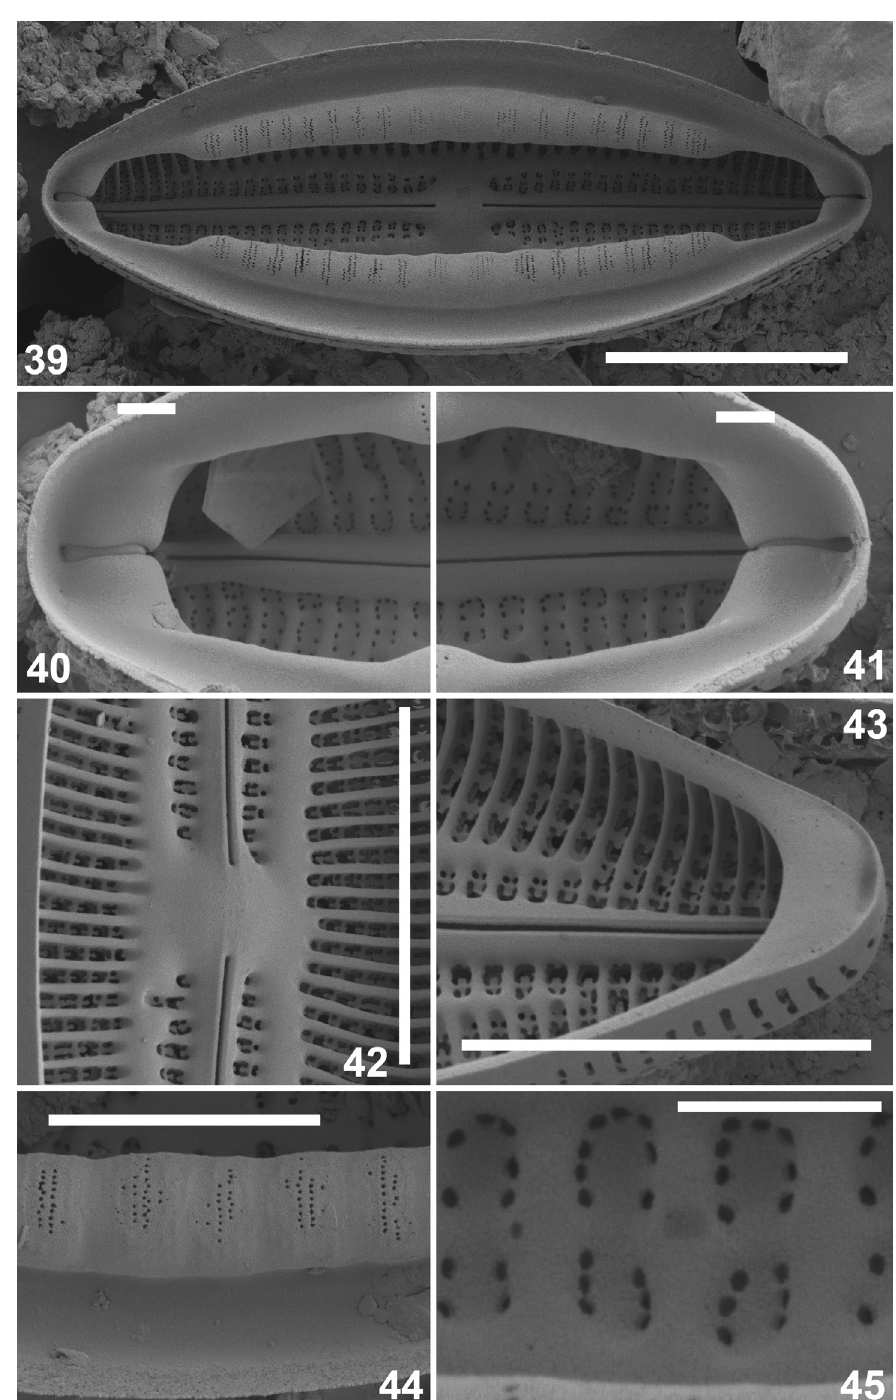
Figs 39–45. Mastogloia belaensis M.Voigt. Scanning electron micrographs (SEM) of valves from the Lac de Guiers population ( Van de Vijver sample SEN-42 ). 39 . SEM internal view of an entire valve with the typical partectal ring. 40–41 . SEM internal details of the partectal ring near the valve apices showing the cleft with the lacunae. 42 . SEM internal detail of the central area. 43 . SEM internal detail of the valve apex with the pseudoseptum. 44 . SEM internal detail of the partecta showing the partectal walls with 2–4 series of small, rounded pores. 45 . SEM internal view of the inner areolae arranged in groups of 4–8 per pseudoloculus. Scale bars: 39–43 = 10 µm; 44 = 5 µm; 45 = 1